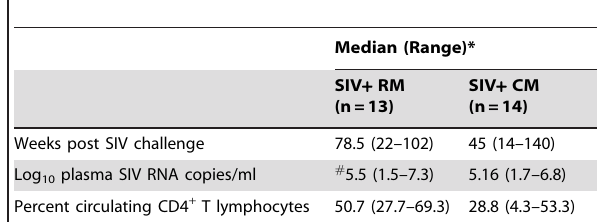
Table 1. Status of SIV-infected rhesus macaques (RM) and cynomolgus macaques (CM) at the time of NKT